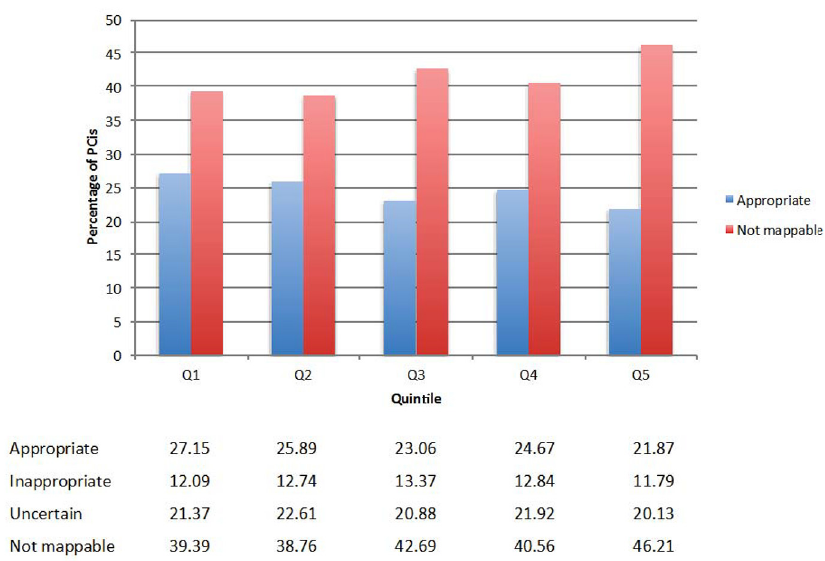
Fig 4. Appropriateness use criteria classification of non- acute PCI across HRR quintiles of PCI utilization. Shown is the application of appropriate use criteria to quintiles of PCI utilization for non-acute PCIs.